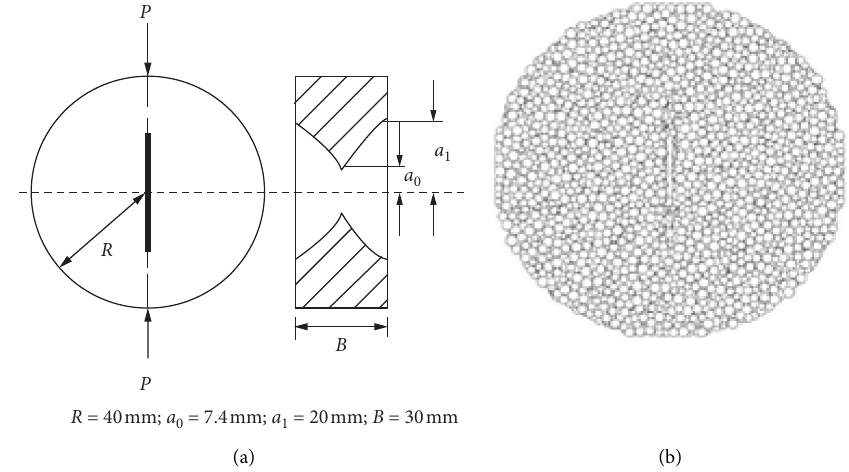
Figure 8: Cracked chevron notched Brazilian disc model. (a) Model size. (b) PFC 3D